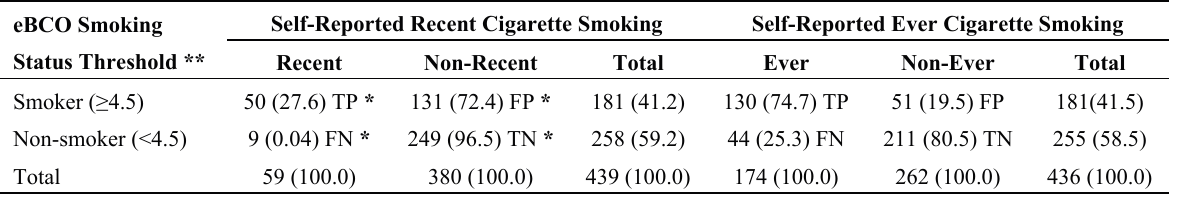
Table 3. Distribution of Students by eBCO Cut-off Point (4.5 ppm) and Self-Report Recent and Ever Cigarette Smoking n